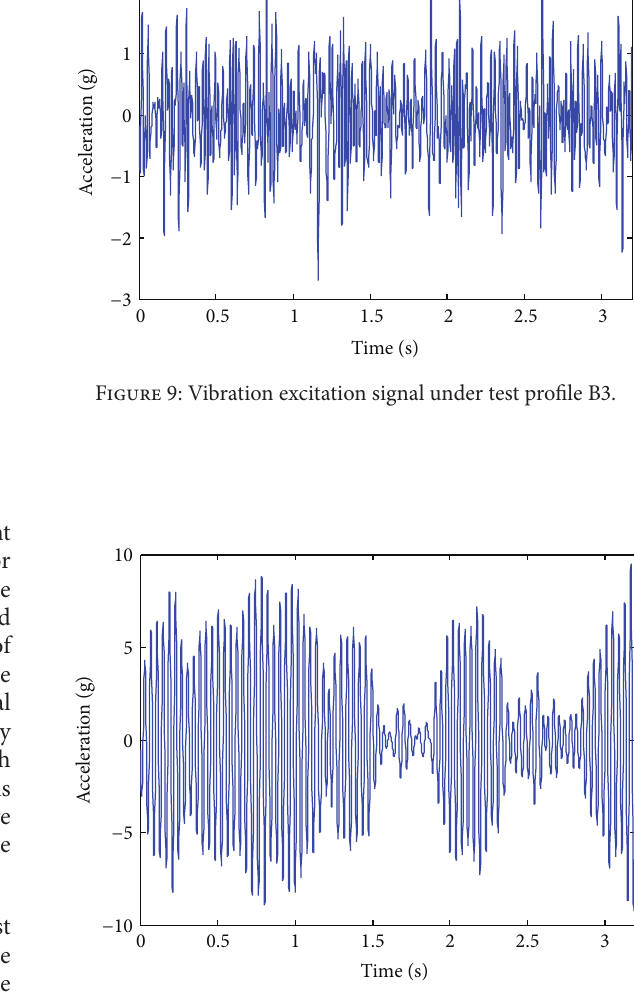
Figure 10: Vibration response signal under test profile B3.